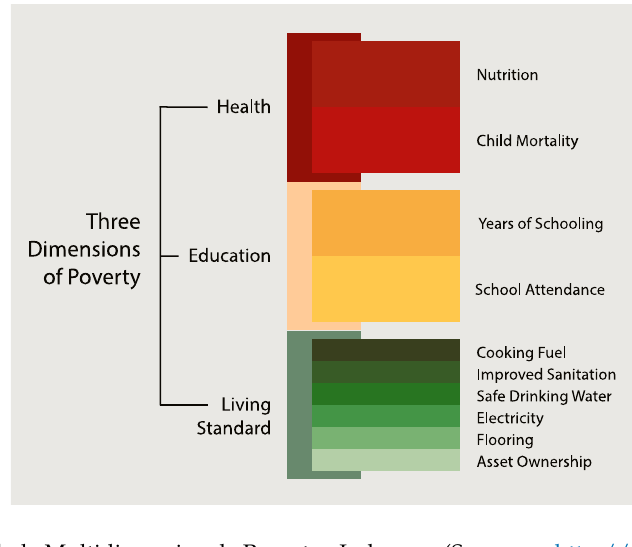
Figure 1. Global Multidimensional Poverty Index. (Source: http://www.ophi.org.uk/multidimensional-poverty-index/) [20].